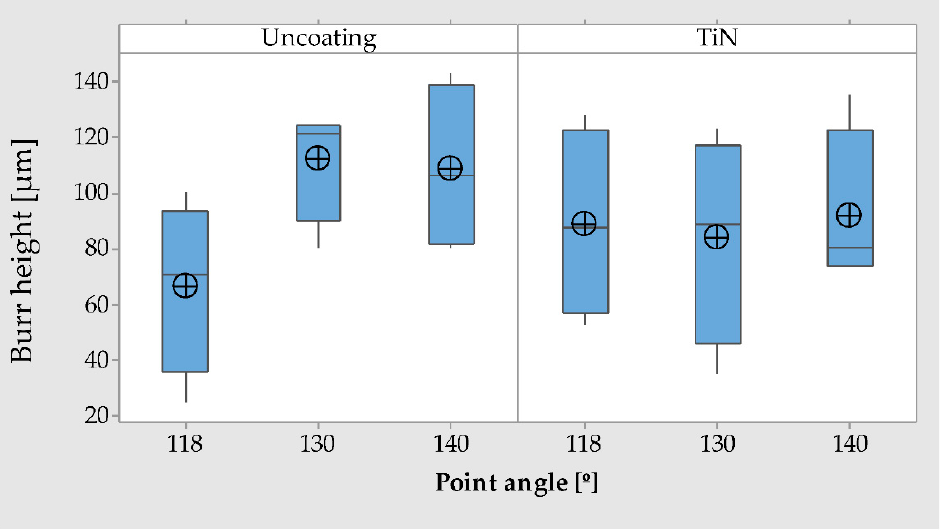
Figure 14. Mean burr height box and whiskers plot graph for interactions between coating and point angle, C * γ .